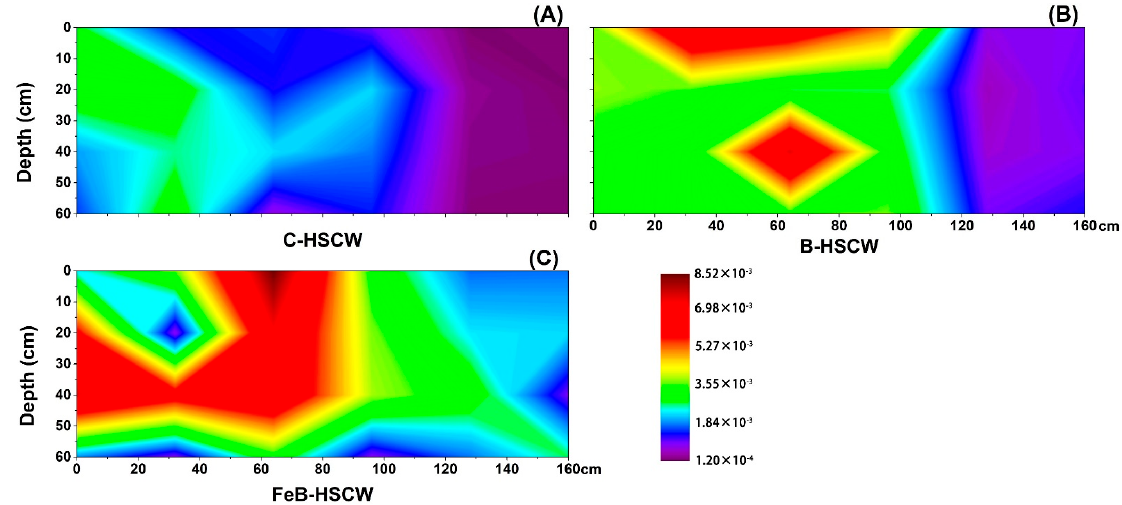
Figure 9. The spatial distribution of cnorB relative abundance in C-HSCW ( A ), B-HSCW ( B ), and FeB-HSCW ( C ) based on interpolated maps. Color scales indicate extrapolated values by kriging. C-HSCW, without biochar and FeB-modified biochar; B-HSCW, with biochar; FeB-HSCW, with FeB-modified